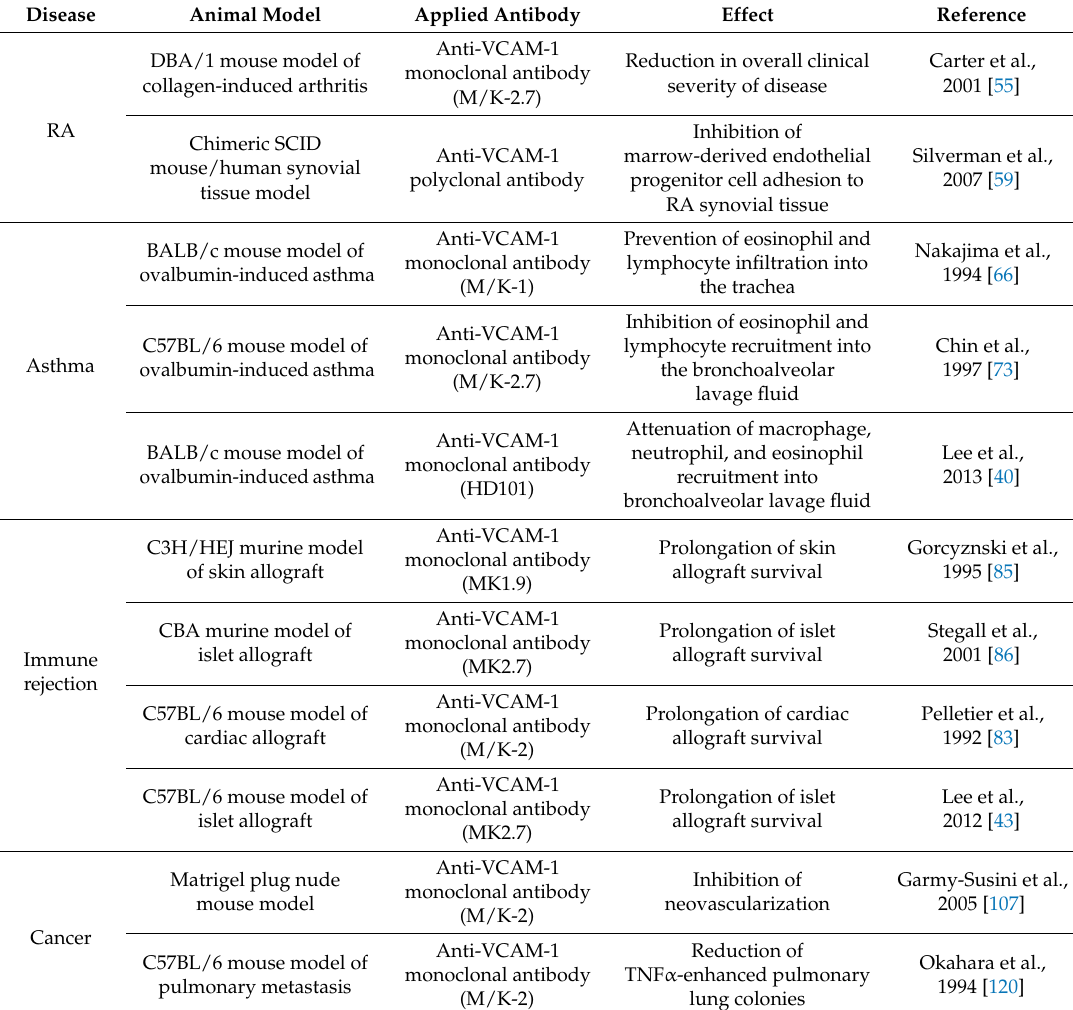
Table 1. Relevance of VCAM-1 in immunological disorders and cancer. RA: rheumatoid arthritis.